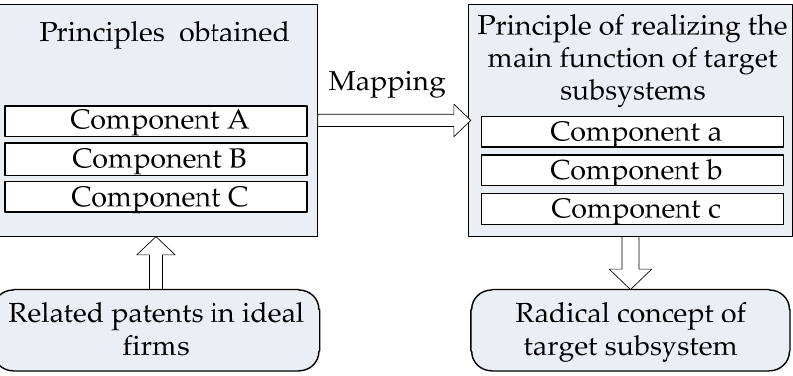
Figure 6. Knowledge transfer and concept generation.